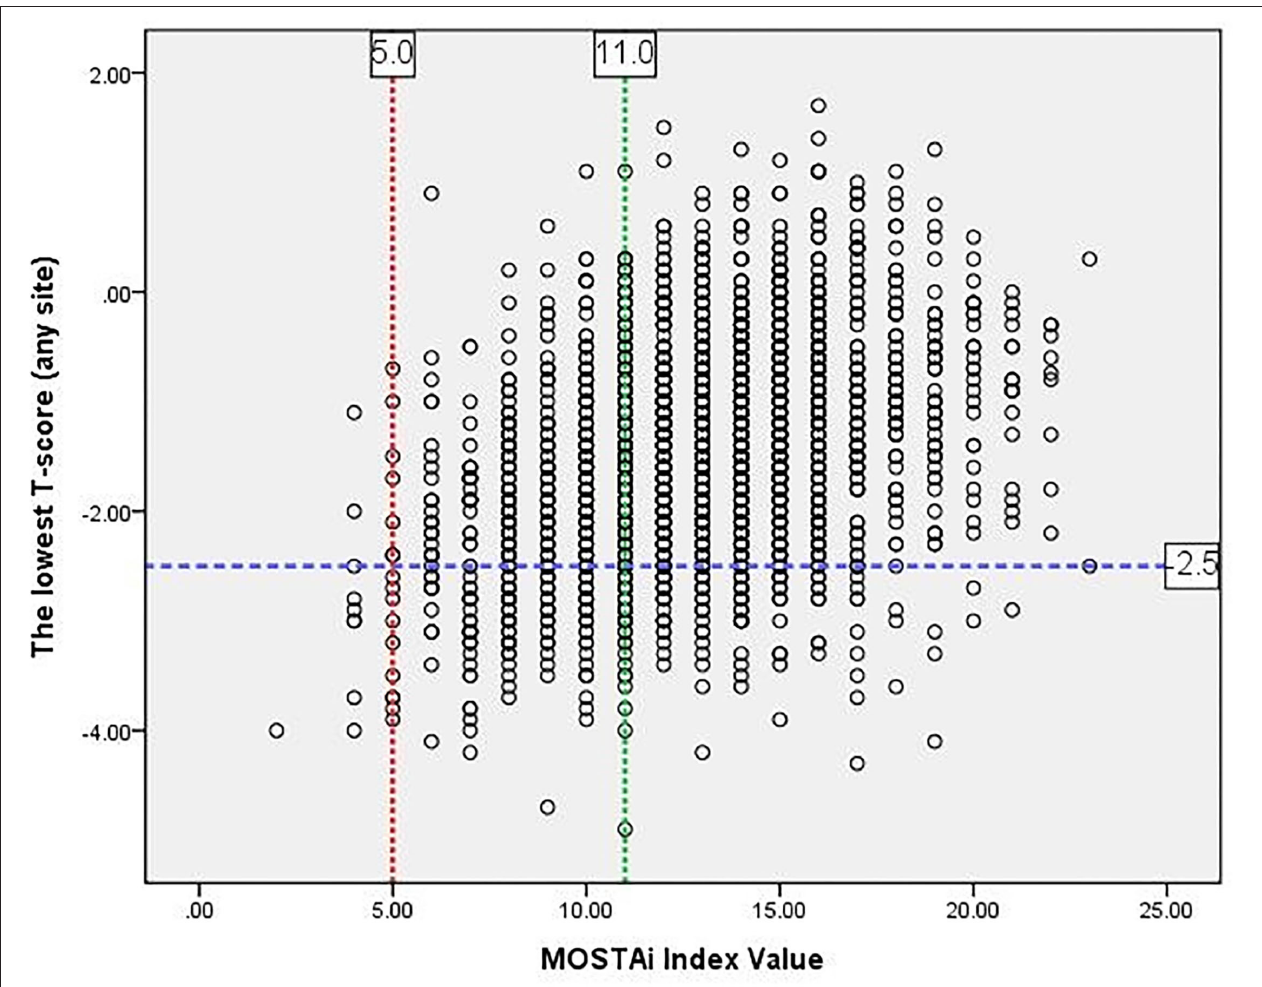
FIGURE 3 | The MOSTAi values vs. lowest T -scores at any site for the development